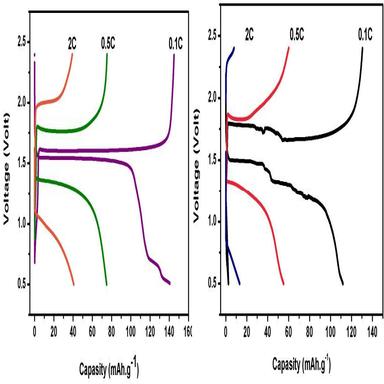
Charge discharge curves of (a) Pristine Li4Ti5O12 and (b) Li4Ti5O12 doped with Al.